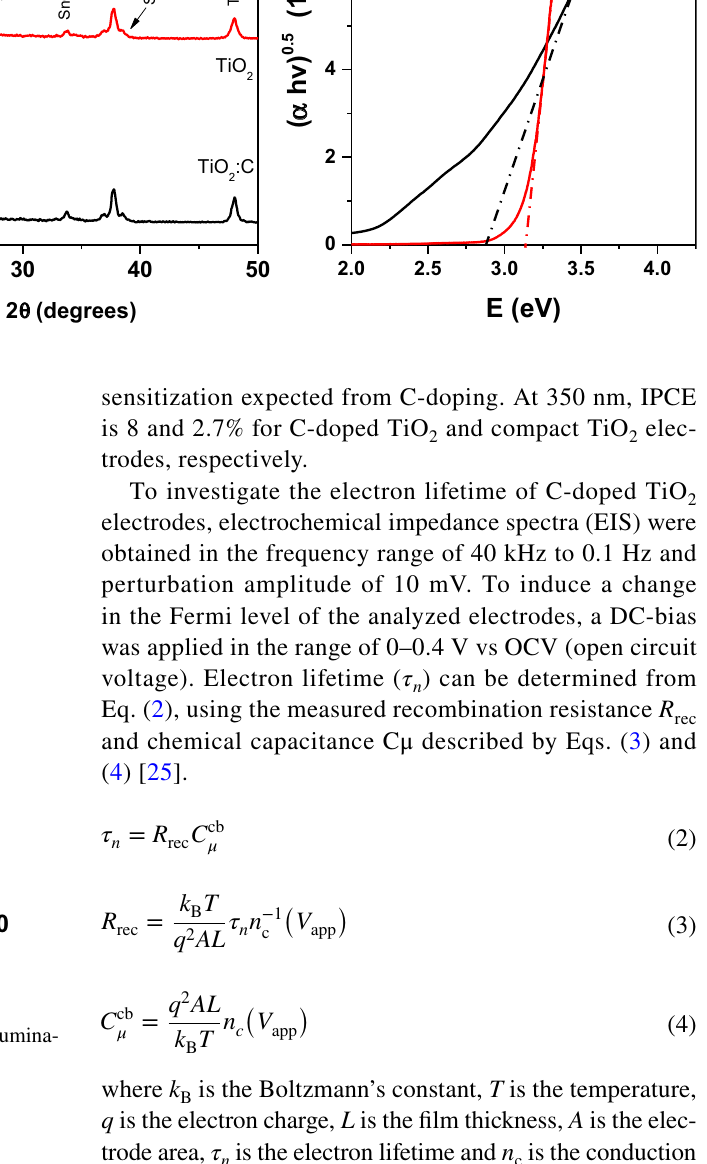
Fig. 2 a XRD patterns of analyzed electrodes. b Indirect band gap determination from absorption coefficient spectra, C-doped TiO 2 (black), compact TiO 2 (red)